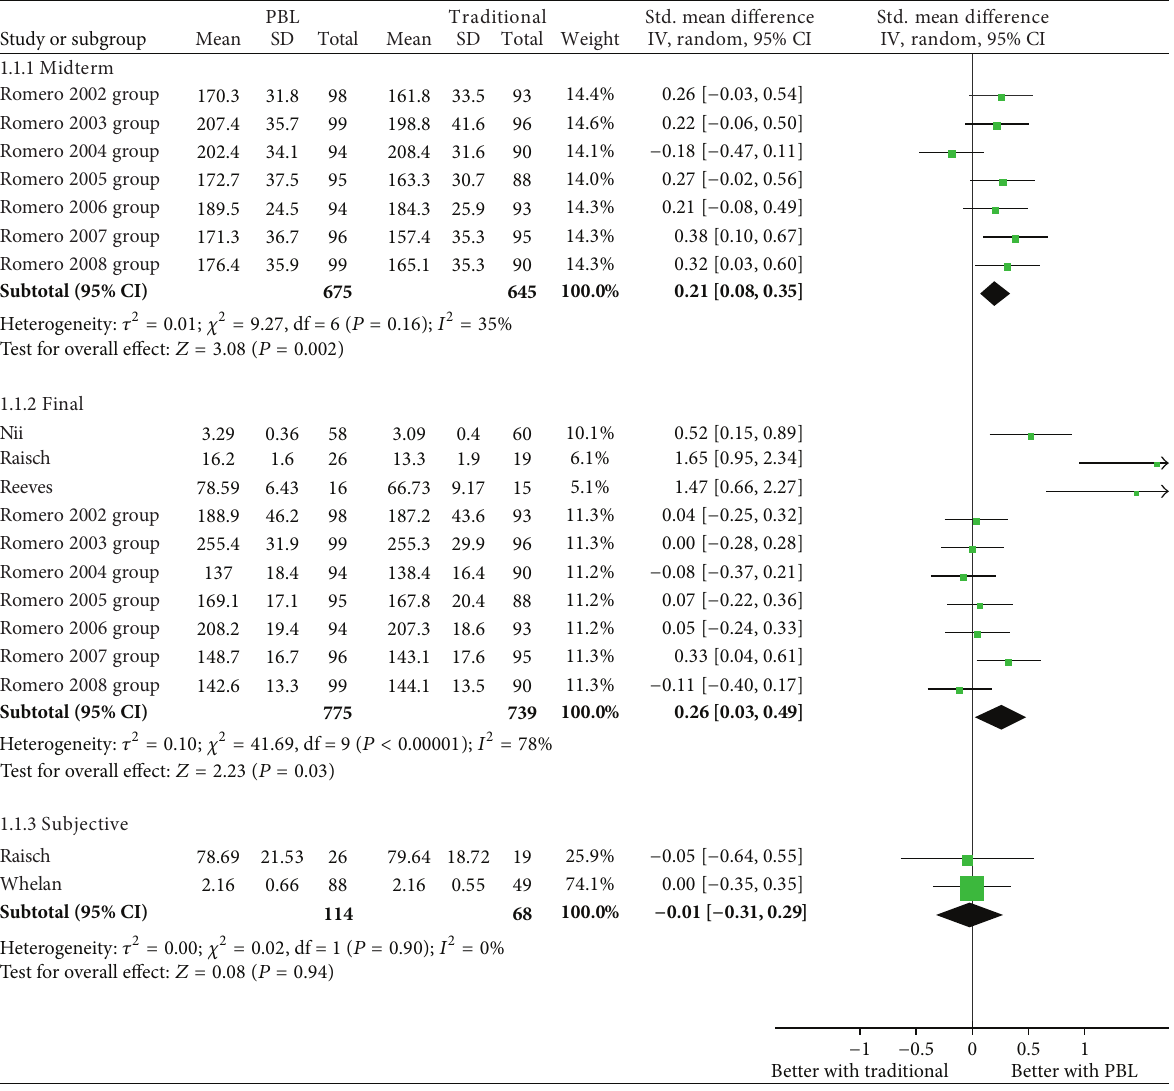
Figure 2: Results of the objective evaluations (final and midterm exams) and subjective